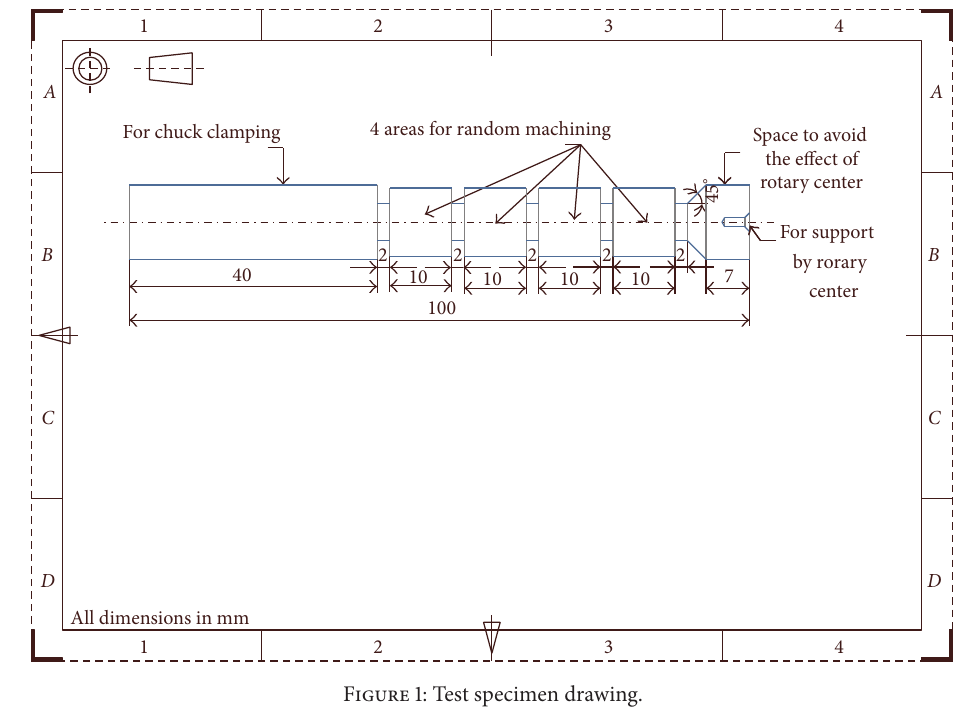
Figure 1: Test specimen drawing.